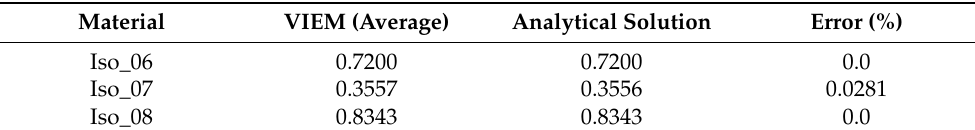
Table 8. Normalized tensile stress component ( σ xx / σ o xx ) within the isotropic spherical inclusion due to uniform remote tensile loading ( σ o xx ).